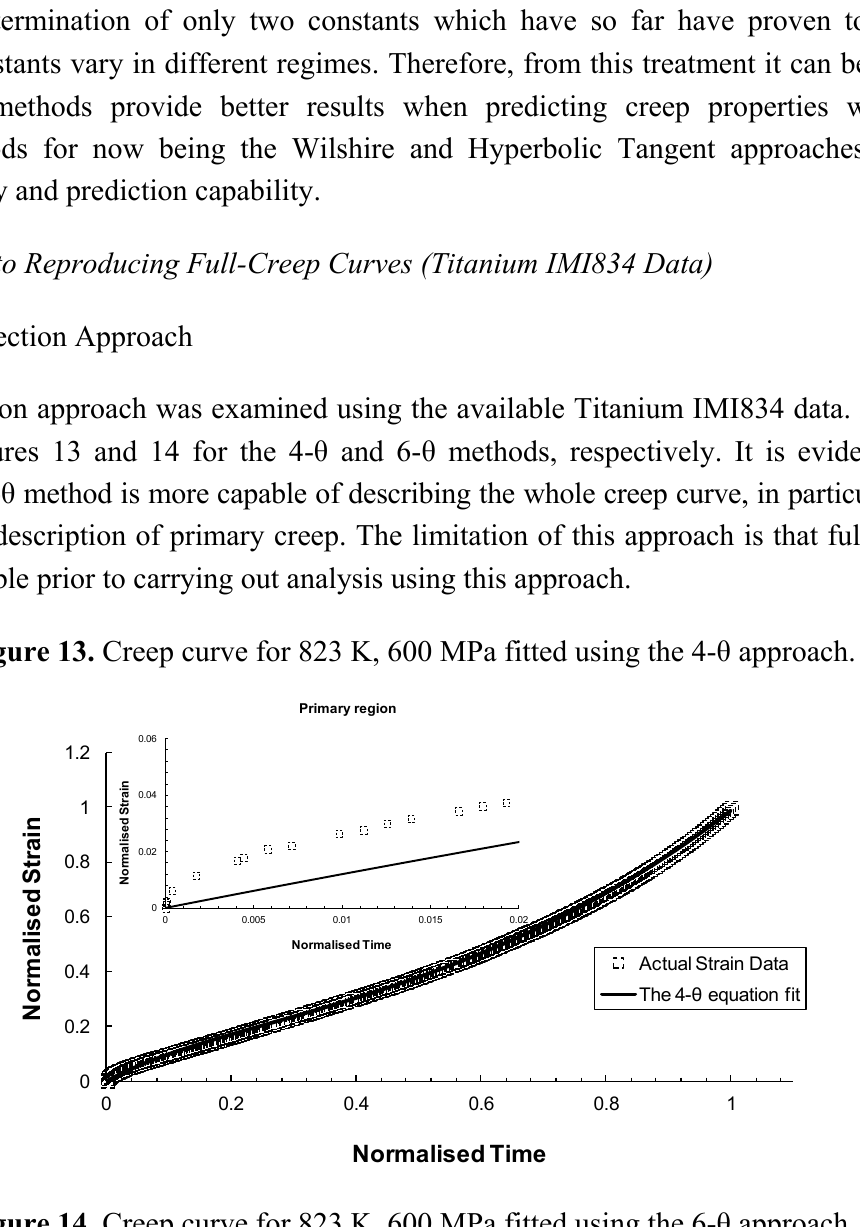
Figure 14. Creep curve for 823 K, 600 MPa fitted using the 6-θ